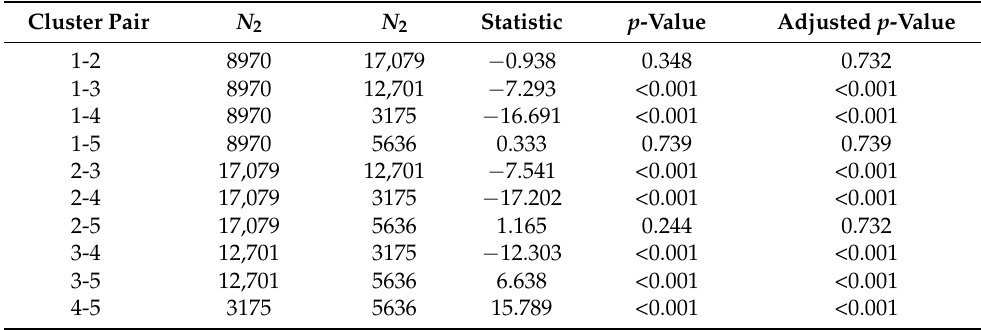
Table A6. Dunn’s test for pairwise multiple comparisons of stochastic dominance with an adjusted P -value. Cluster